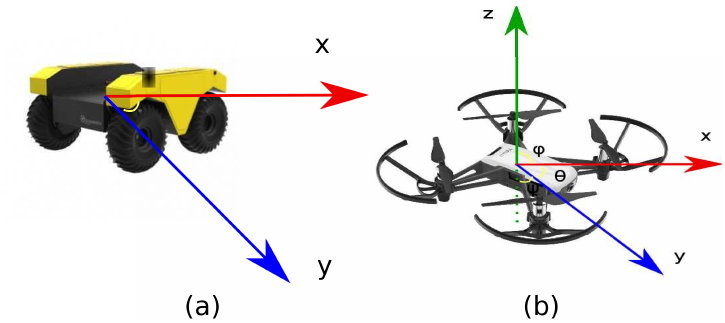
Figure 5. Kind of agents based on movements. ( a ) 2D agent. ( b ) 3D